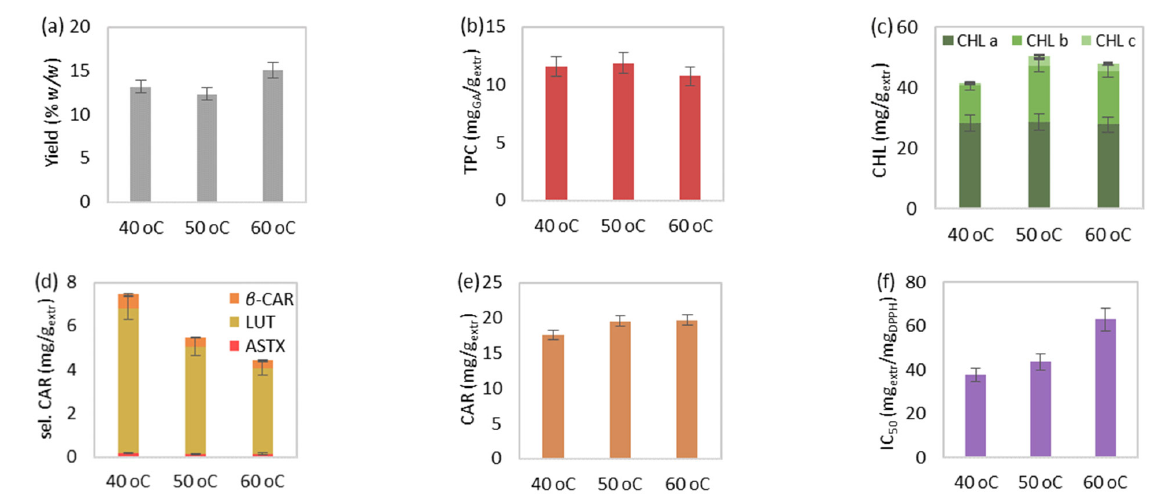
8 of 26 Figure 2. The effect of solvent ‐ to ‐ biomass ratio on MAE’s ( a ) extraction yield, extract’s total ( b ) phe ‐ nolic and ( c ) chlorophyll content, ( d ) select€and ( e ) total carotenoid content, and ( f ) antioxidant ac ‐ tivity. The extraction conditions of the single ‐ factor experiments were maintained at 50 °C, 15 min and 550 watts. 3.1.3. Effect of Temperature The effect of increasing temperature, from 40 to 50 and eventually 60 °C, on the MAE at 15 min, 55 mL solv /g biom and 550 watts is illustrated in Figure 3. The initial increase from 40 to 50 °C did not favor the extraction yield, while further temperature elevation led to improved recovery of total extract at 60 °C (Figure 3a). Moreover, the extract’s total pig ‐ ment content was moderately improved during temperature increase (Figure 3c,e). The above observations could be justified by the decrease of solvent’s viscosity from 40 to 60 °C, and therefore an increase of its solvation power [57,58]. On the other hand, the extract’s antioxidant activity deteriorated during the temper ‐ ature increase (Figure 3f). This could be attributed to the reduced content of lutein (Figure 3d), which presents much higher antioxidant activity compared to other carotenoids, e.g., 15 ‐ and 10 ‐ time folds of lycopene and β ‐ carotene [59]. In particular, the selected carotenoid content presented a downward trend, probably due to the domination of their degrada ‐ tion instead of their extraction, also noted in the literature during microwave radiation at